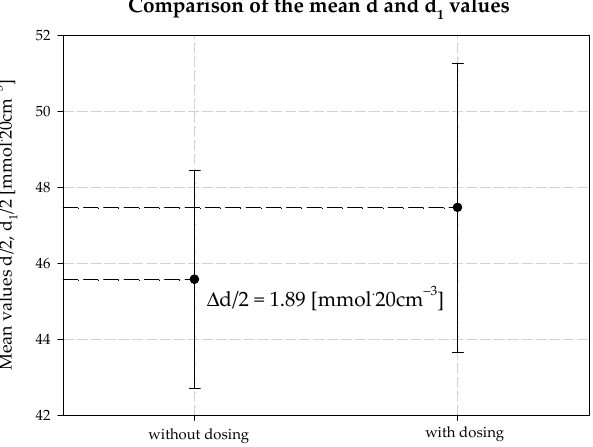
values values 1 1